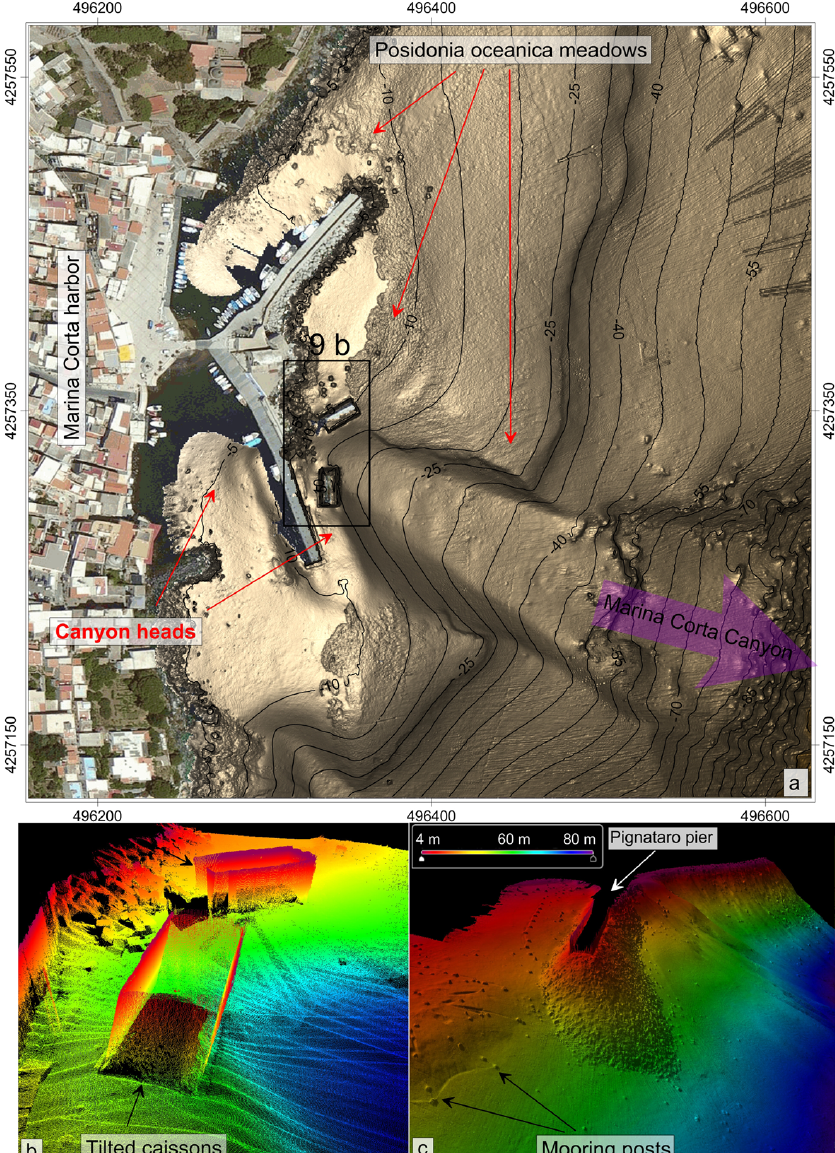
Figure 9. (a) Shaded relief of the coastal sector facing Marina Corta harbor (for location see the inset in Figure 6) showing the Marina Corta Canyon and anthropic structures; (b) 3-D views of the tilted caissons and mooring posts and the outer part of the mole at Pignataro harbor (for location see the inset in Figure